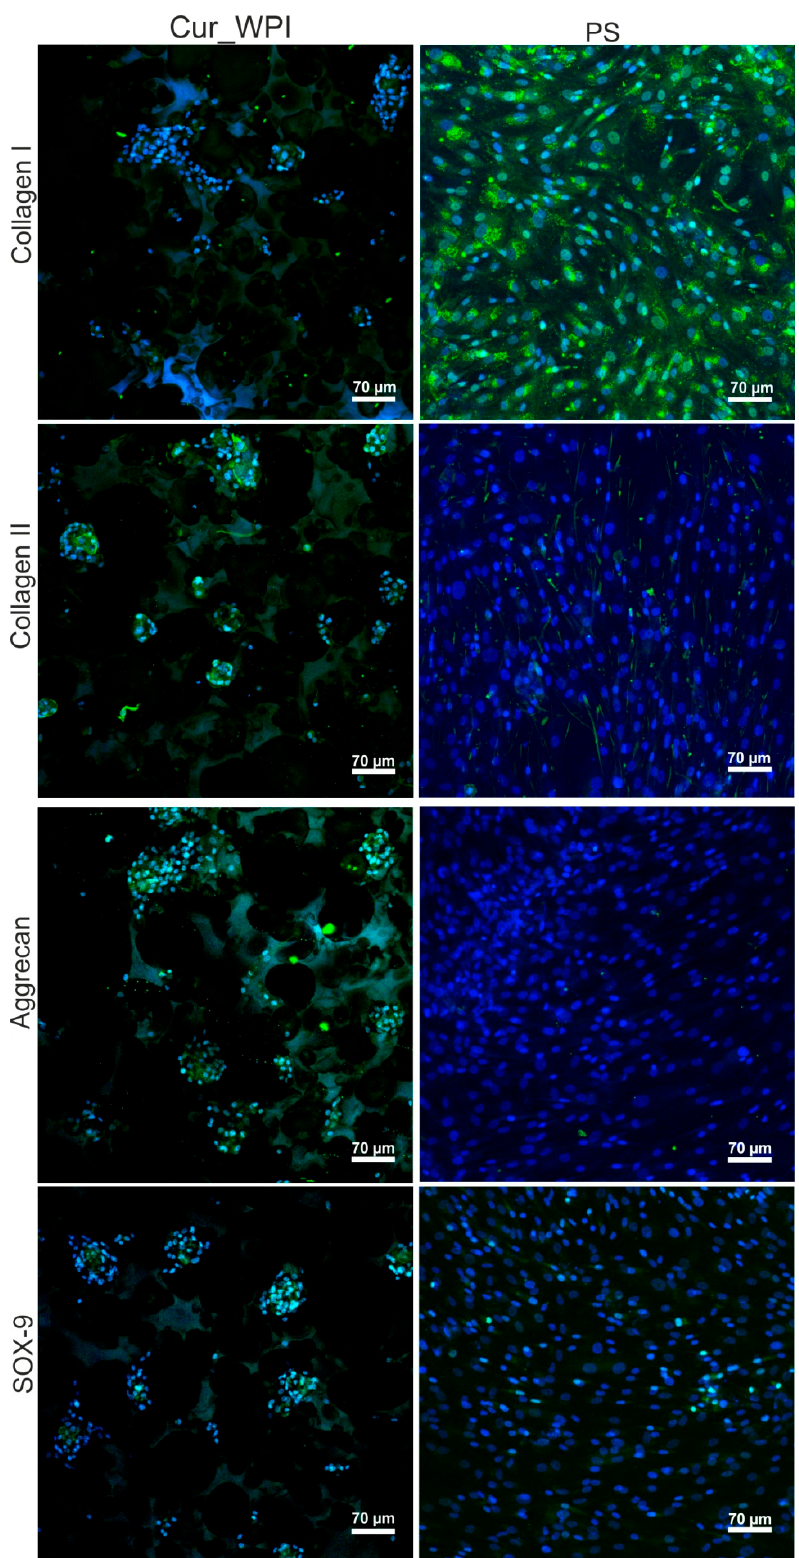
Figure 8. Confocal microscope images presenting characteristic markers—collagen II, aggrecan, and SOX-9 after the 12-day culturing of chondrocytes on Cur_WPI biomaterials and polystyrene (PS). Collagen I was also visualized to determine chondrocyte dedifferentiation towards fibroblast-like cells. Nuclei emitted blue fluorescence, while evaluated markers gave green fluorescence (visible green fluorescence in the structure of biomaterial was emitted by WPI); magnification 200×, scale bar equals 70 μ m.